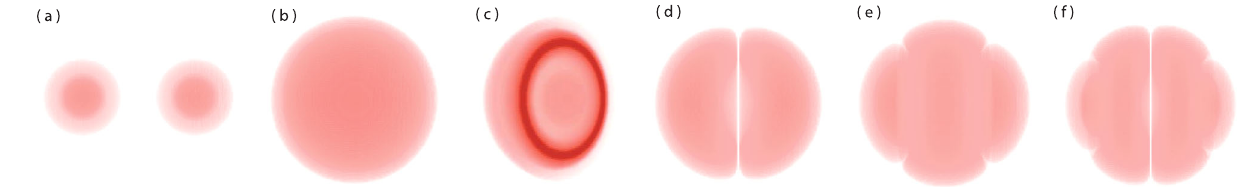
Fig. 1 Nuclear distribution of hydrogen molecules. a Nuclear distribution of Gaussian without a coupling between nuclear spins and a nuclear rotational state. Nuclear distributions of para ( b , c ), ortho ( d ), para-2 ( e ), and ortho-2 ( f ) that follow the nuclear spin statistics of the quantum rotor. The internal shell structure cut in half of para is explicitly shown in ( c ). Nuclear nodes appear in the shell-type species depending on the rotationally-excited